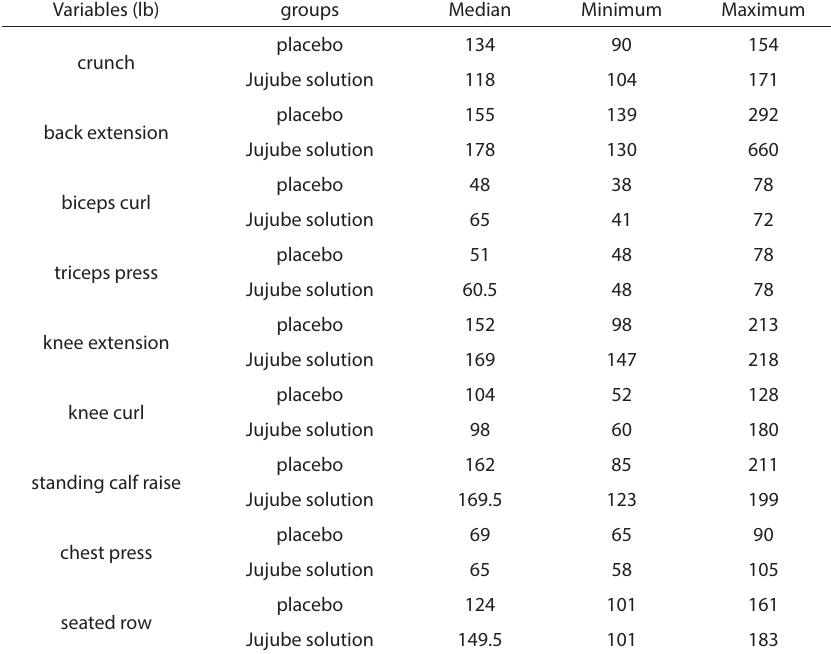
Table 1. Exercise’s 1-RM Records of Participants